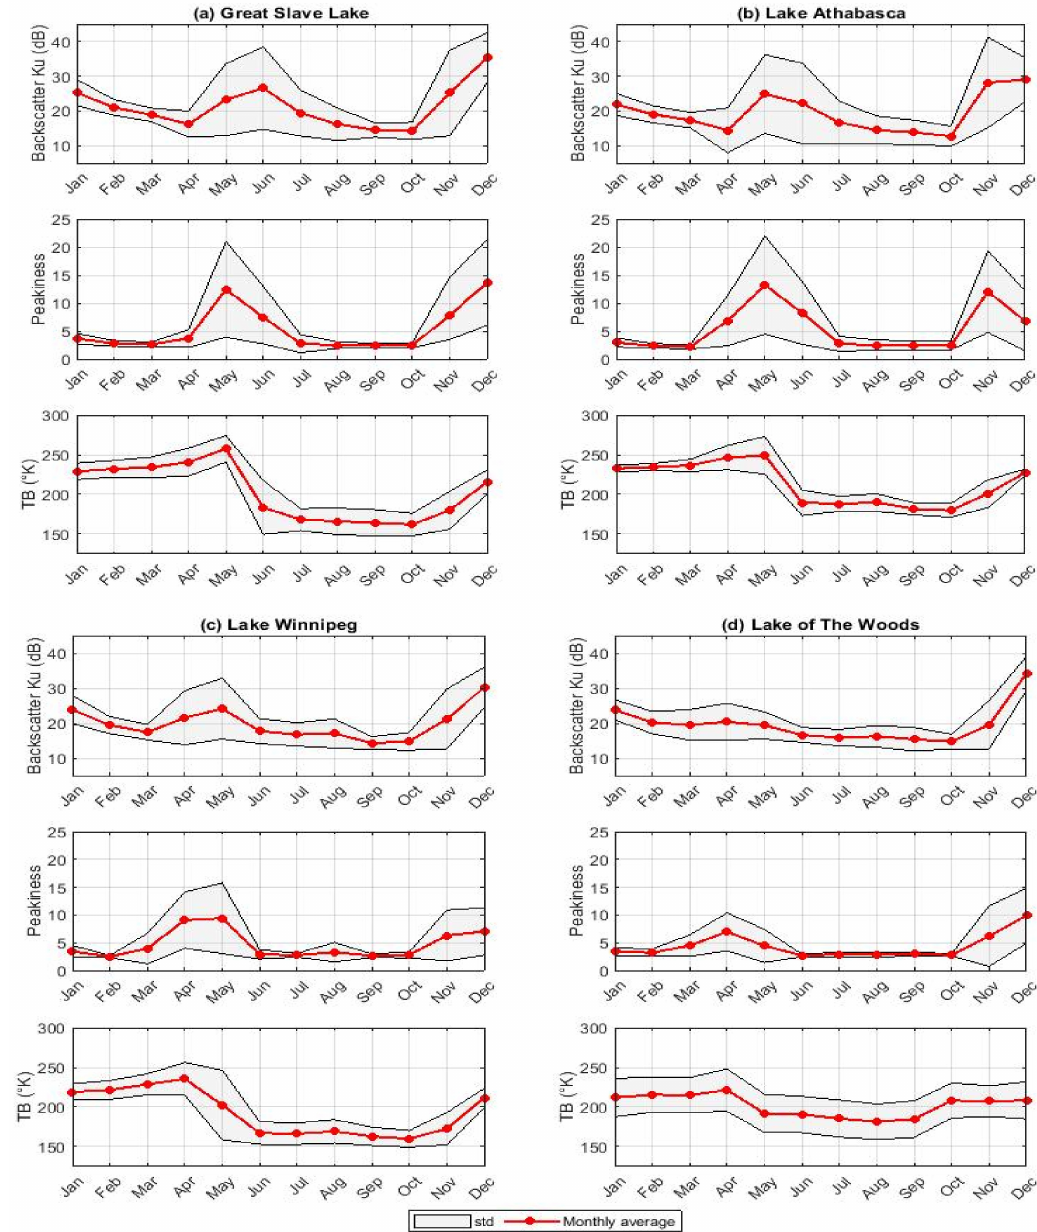
Figure 6. Monthly average (in red) and std (in grey) time series of backscatter, peakiness and average brightness temperature corresponding to the period 8 September 2008 to 21 September 2016 and for all Jason-2 tracks that have a cross-section with (a) Great Slave Lake, (b) Lake Athabasca, (c) Lake Winnipeg and (d) Lake of the